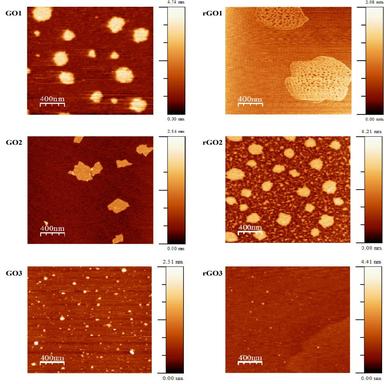
Typical AFM images of GO (left) and rGO samples (right).